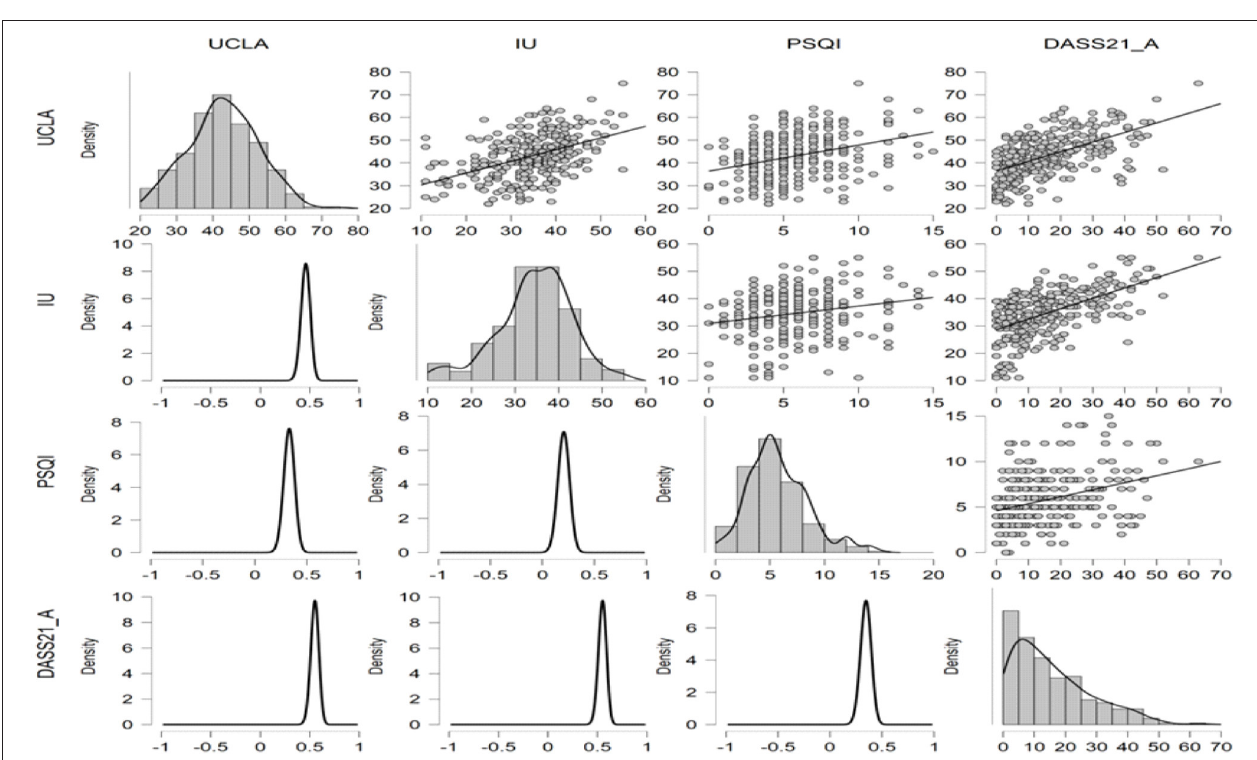
FIGURE 2 | Scatter plots, density plots, and posterior probability distribution plots among variables.